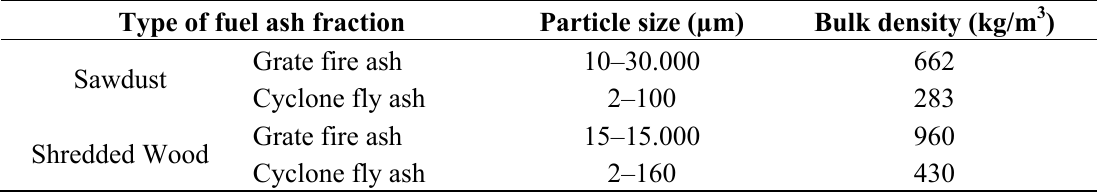
Table 4. Showing particle size and bulk density in the combustion of sawdust and shredded wood